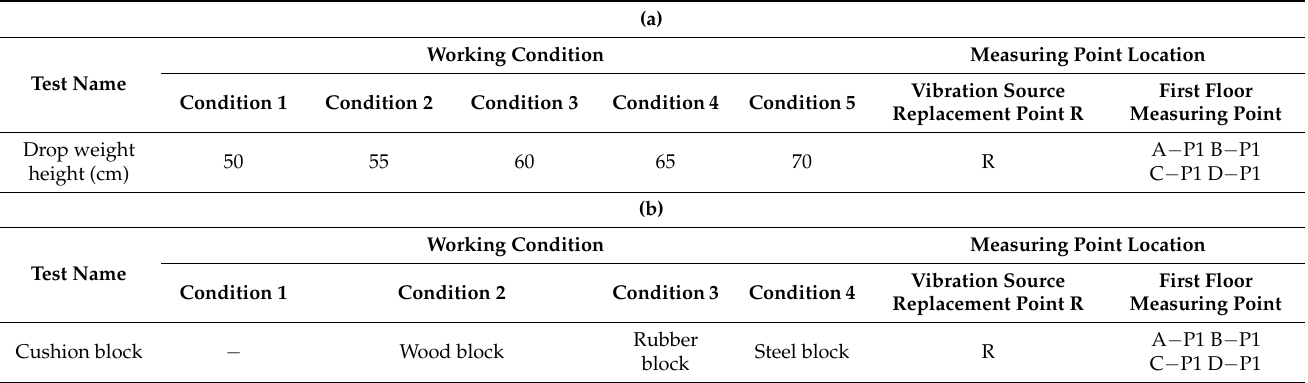
Table 1. Working conditions of the drop weight test: ( a ) Different excitation heights, ( b ) Different cushion blocks.